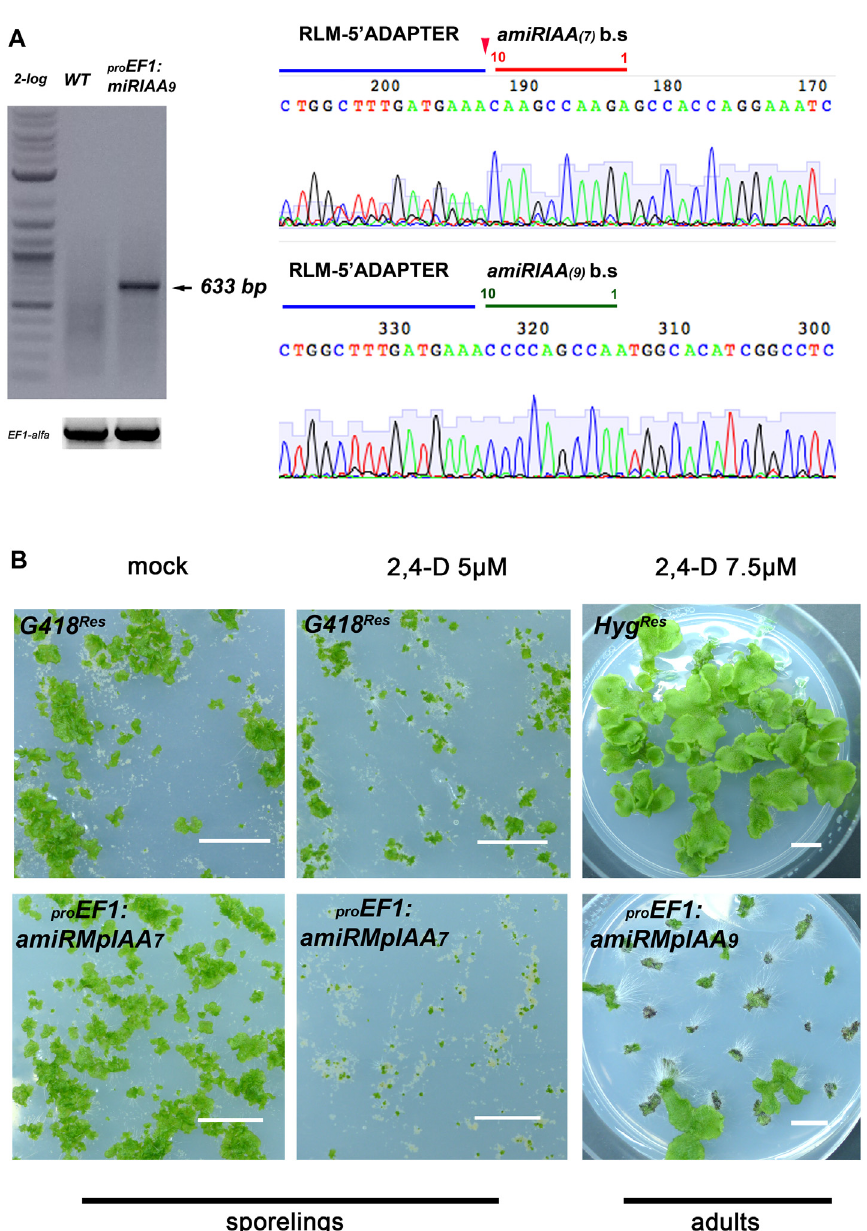
Fig 2. MpIAA represses auxin signaling in M . polymorpha . (A) RLM RACE of amiRMpIAA expressing lines. Left panel shows gel electrophoresis of RLM-RACE products. Right panel shows direct sequencing of the 633bp RLM-RACE product from amiRMpIAA 9 . Sequencing detected the expected cleavage of MpIAA between bases 10/11 of both miR sequences. (B) Auxin hypersensitivity in knock-down MpIAA lines at both the sporeling and adult stages. At the sporeling stage, pro EF1 : amiRMpIAA 7 sporelings grown on 5 μ M 2,4-D from germination have severely affected area compared to G418 Res controls. In the adult stage plants were grown for 16 days on B5 media prior to treatment with 2,4-D. pro EF1 : amiRMpIAA 9 treated with 7.5 μ M 2,4-D for ten days form ectopic rhizoids compared to Hyg Res controls. In all panels, each of the plants is an independent transformant. Scale Bars = 1